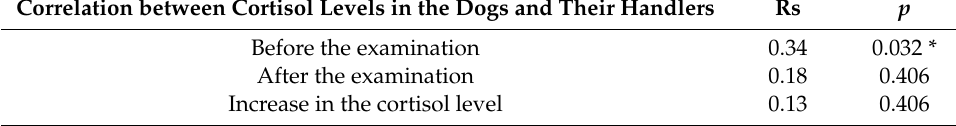
Table 3. Spearman’s rank-order correlation coe ffi cient r between cortisol levels in the dogs and their